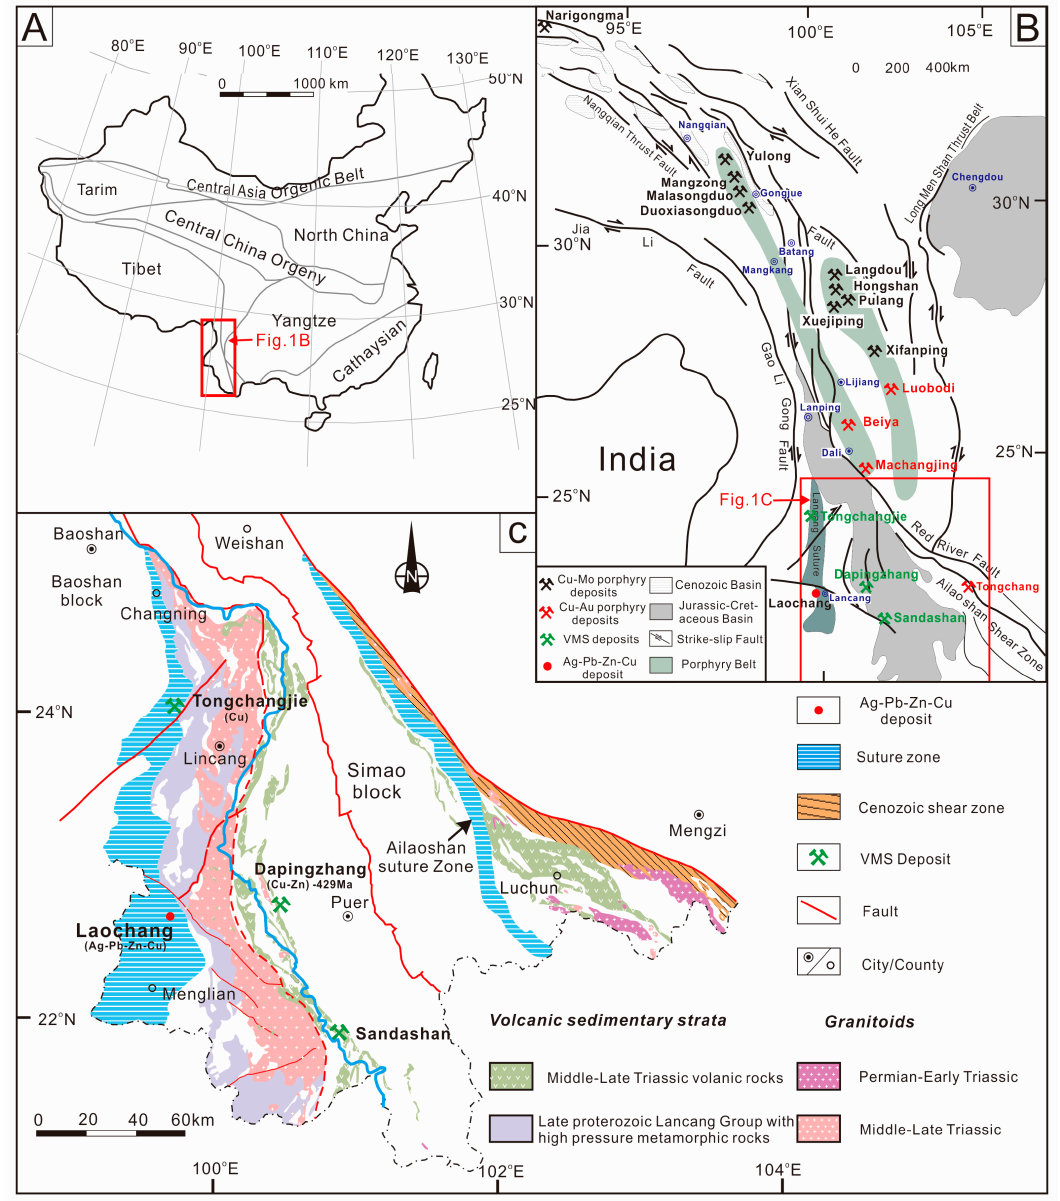
Figure 1. ( A ) Geotectonic framework map of China showing the location of the Sanjiang Orogen; ( B ) Geologic map of the Southwest Sanjiang Tethys metallogenic belt that shows the porphyry and volcanogenic massive sulfide (VMS) deposits (modified after Li et al. [8]); ( C ) The Lancang river zone showing the distribution of the major tectonic units, igneous rocks and location of the Laochang Ag-Pb-Zn-Cu deposit (modified after Deng et al.